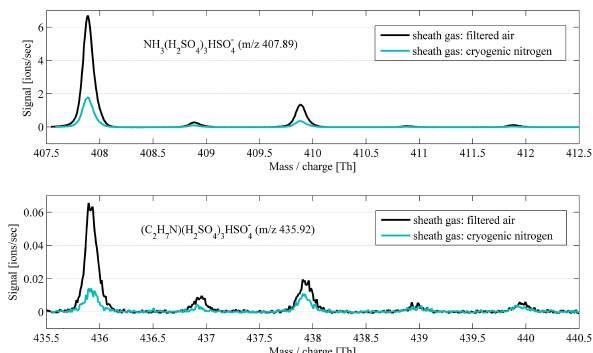
Figure 8. Portion of a time series measured at SMEAR II boreal forest field station. While ammonia concentration exceeds the de- tection threshold determined by the zero measurement (indicated by the blue shaded regions), the DMA signal increases when zero air is fed into the instrument, indicating that DMA concentrations in ambient atmosphere were at maximum 150ppqV during the mea- surement period. Evaluation of ambient concentration is limited by apparent contamination in “zero air” from N2 flushing of inlet lines. That is, the [DMA/EA] depicted here represents the upper limit of ambient